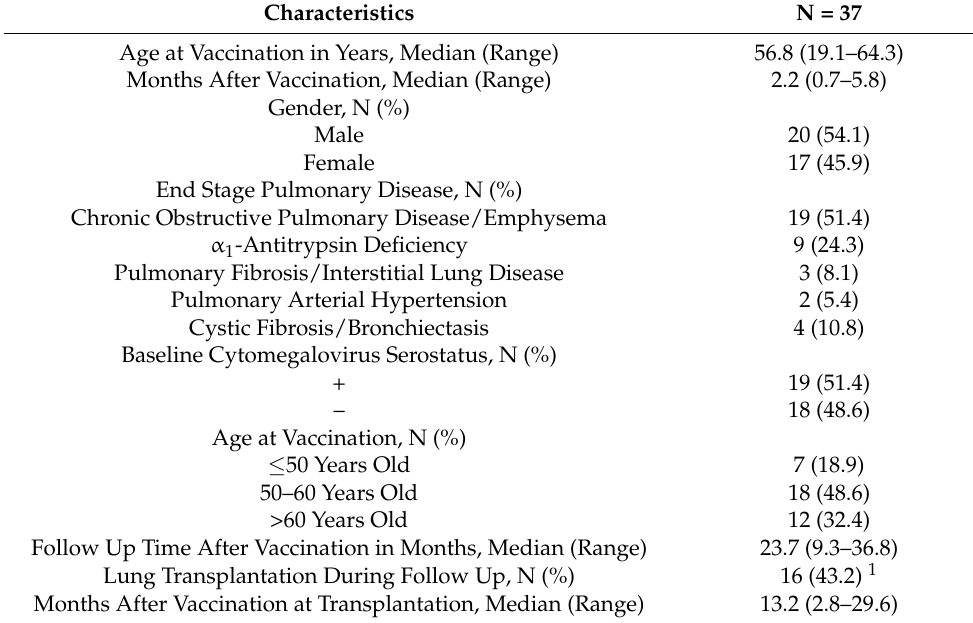
Table 1. Characteristics of the participants at